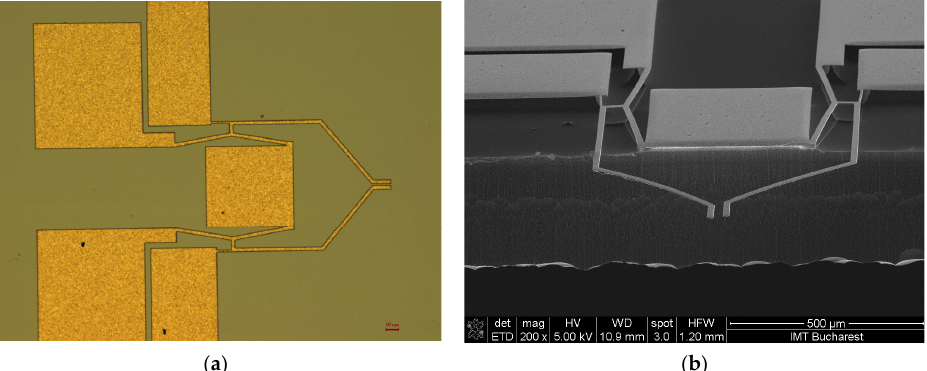
Figure 3. Images of a fabricated micro-tweezer: ( a ) Optical image before release; ( b ) SEM image after release.